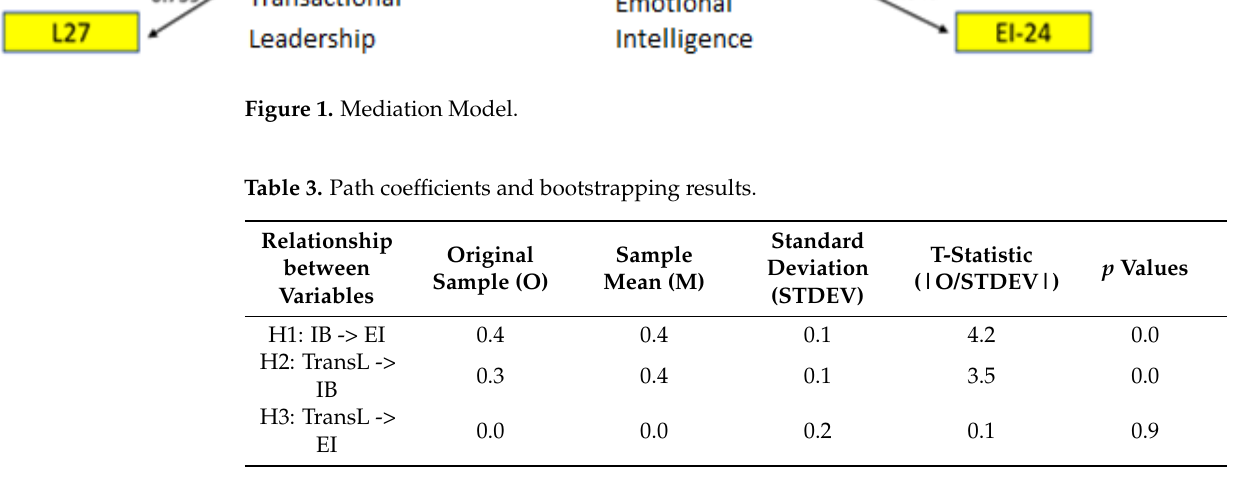
Table 4. Mediating